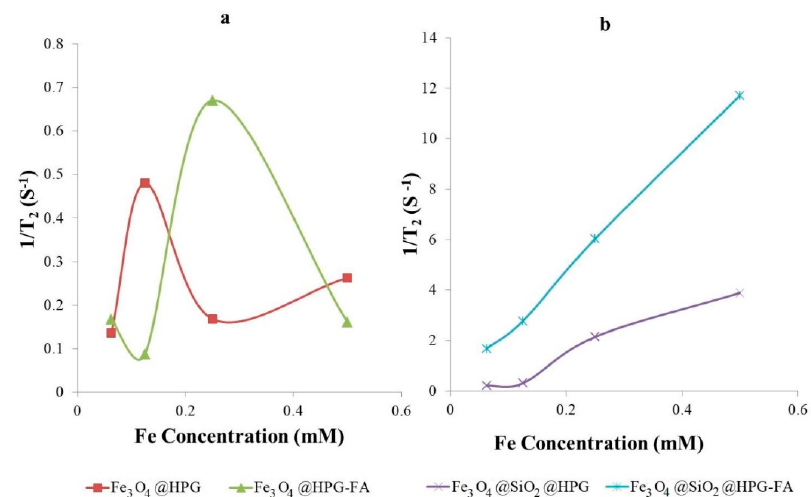
Figure 8. 1 / T 2 values as a function of concentration of ( a ) Fe 3 O 4 @HPG and Fe 3 O 4 @HPG-FA; ( b ) Fe 3 O 4 @SiO 2 @HPG and Fe 3 O 4 @SiO 2 @HPG-FA. Table 1. In vitro Transverse relativities ( r 2 ) of MRI contrast agents. (cid:2200) (cid:2779) [mM − 1 S − 1 ]